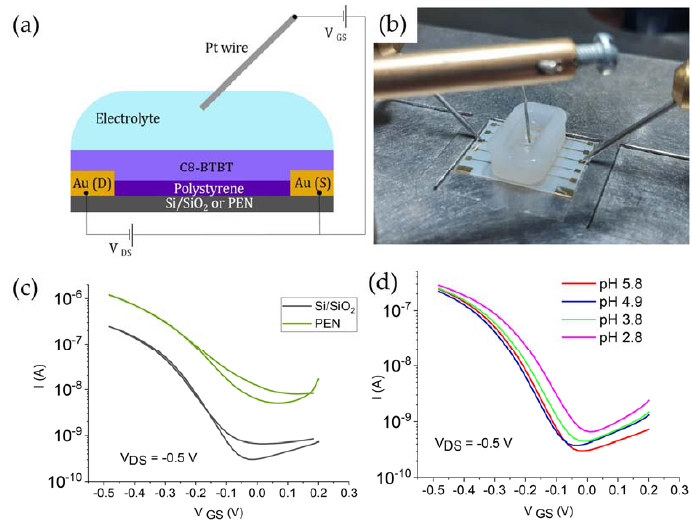
Figure 1. ( a ) The device layout; ( b ) a photo of the setup used for electrical measurements with the device manufactured on PEN substrate; ( c ) typical transfer characteristics of an EGOFET recorded in 0.1 M NaCl with pH = 5.8 for devices manufactured on Si/SiO 2 substrate (black) and PEN substrate (green); ( d ) typical transfer characteristics evolution of an EGOFET during adding of HCl for the device manufactured on Si/SiO 2 substrate.